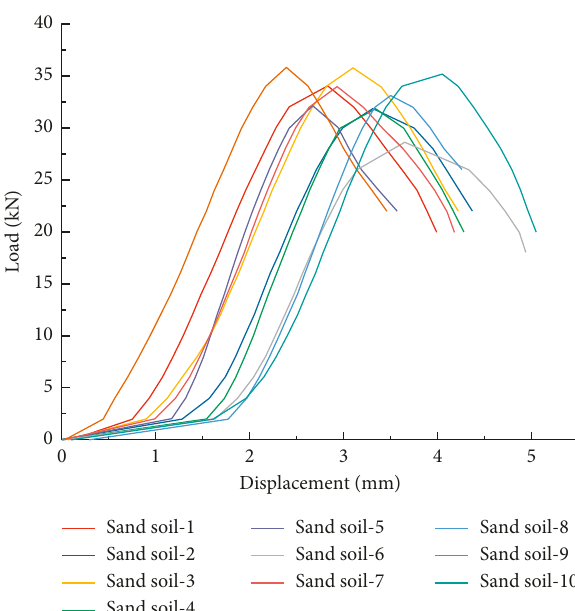
Figure 7: The Load-displacement curve of sand soil.